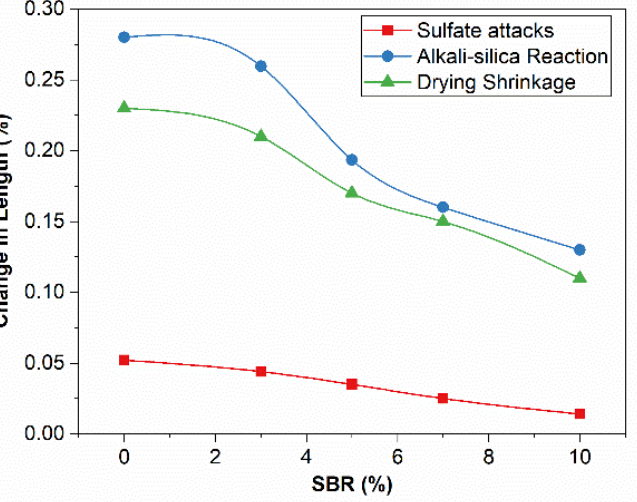
Figure 5. Variation in Length (%) of Mortar Bars Due to Expansions Caused by Sulfate Attacks and ASR, and Shrinkage Caused by Drying (ASTMC 490).